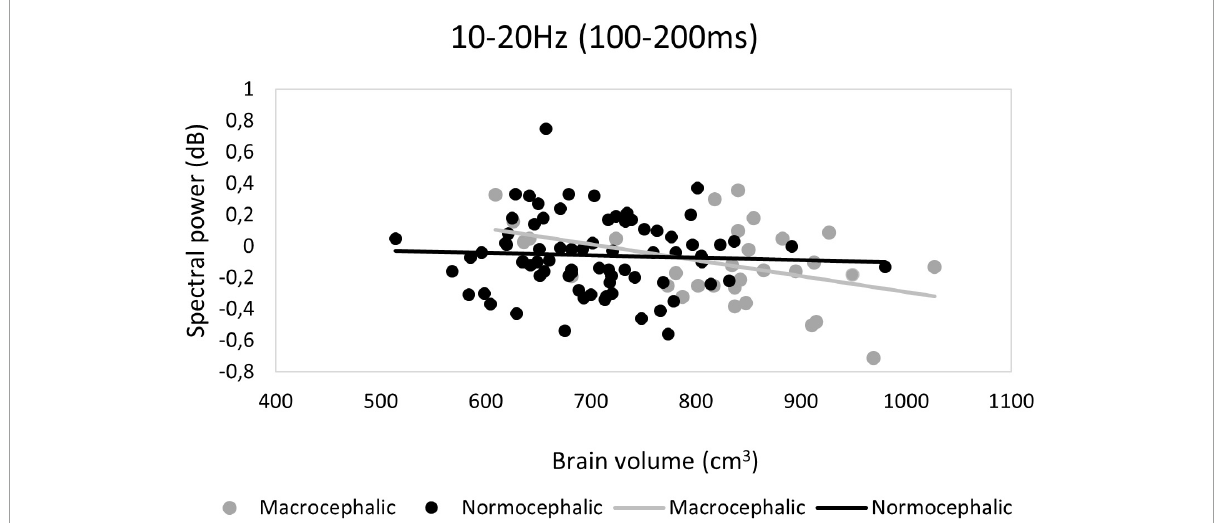
FIGURE5 Ten to twenty Hertz time-frequency window (TFW). Change detection response: Scatter plot demonstrating the interaction between group, brain volume and quadratic slope. A decrease in change detection response was associated with increasing brain volume only in the macrocephalic group (all ROIs) in terms of spectral power. dB, decibels.